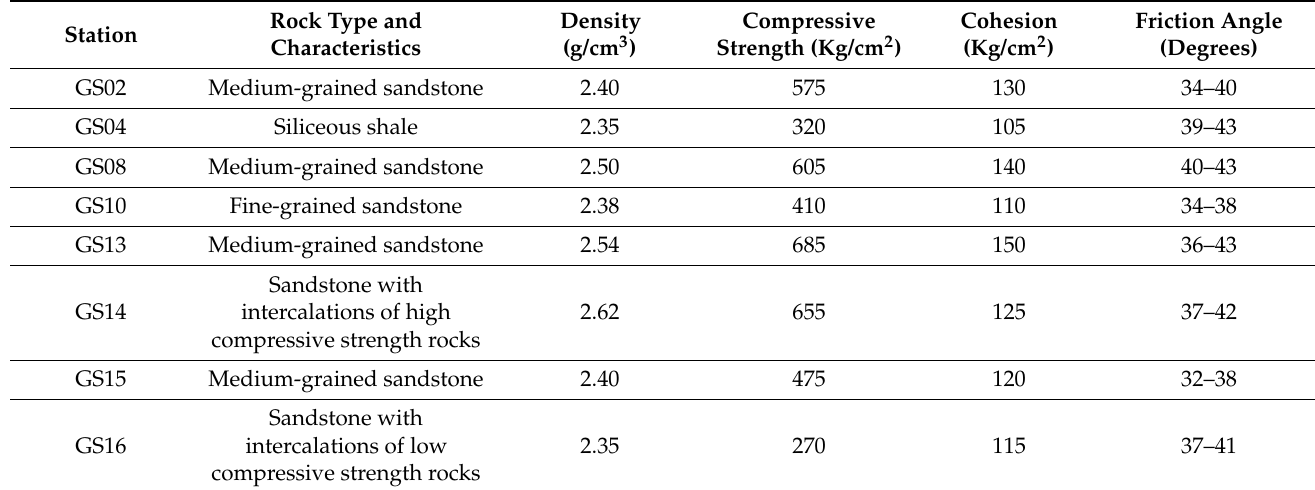
Table 11. Physical – mechanical properties of rock samples from geomechanical stations.